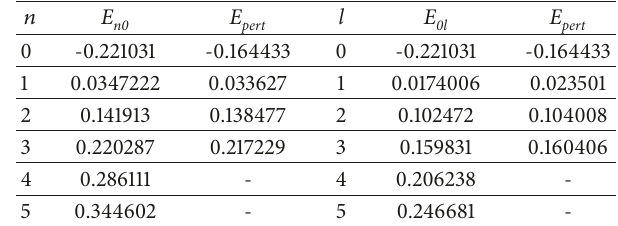
Table 1: Comparisons of the perturbative energy eigenvalues ( 𝐸 𝑝𝑒𝑟𝑡 ) (in GeV) with those obtained by direct application of AIM ( 𝐸 𝑛𝑙 ) for the potential parameters 𝐴 = 1 and 𝐵 = 1 GeV, and for the reduced mass 𝜇 = 1/2 GeV.